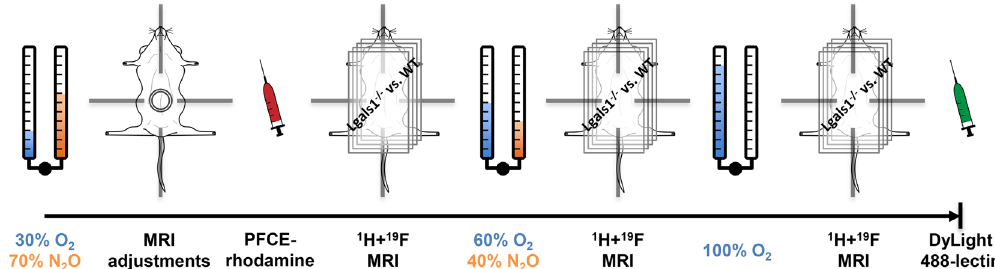
Figure 1. Experimental design. Freely breathing Lgals1 WT and KO animals underwent serial MRI at different levels of oxygen in breathing air after receiving PFCE emulsion i.v. Fluorophore-coupled lectin was injected at the end of the experiment in order to label the vasculature for histological